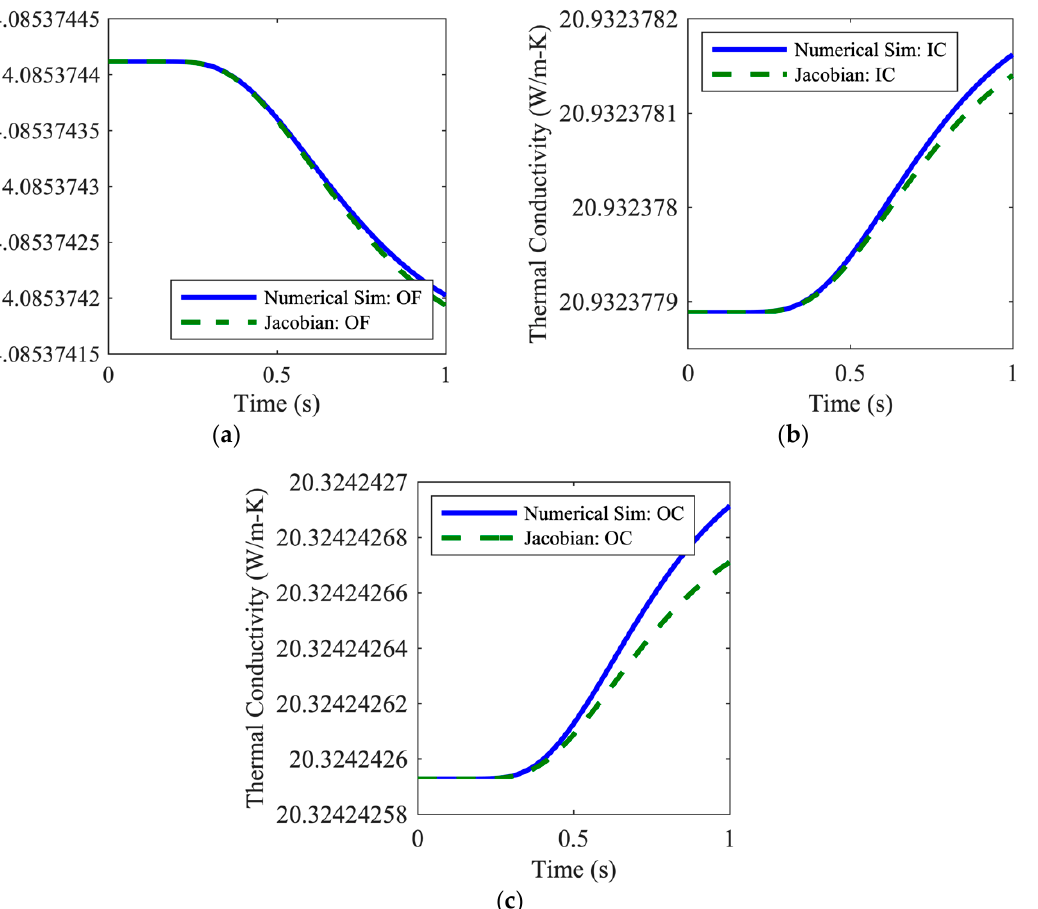
Figure 5. Thermal conductivity evolutions at other radial positions (OF = outer fuel, IC = inner clad- ding, and OC = outer cladding) across from the 1% centerline temperature perturbation. (a) Thermal conductivity evolution at the outer fuel node. (b) Thermal conductivity evolution at the inner clad- ding node. (c) Thermal conductivity evolution at the outer cladding node.